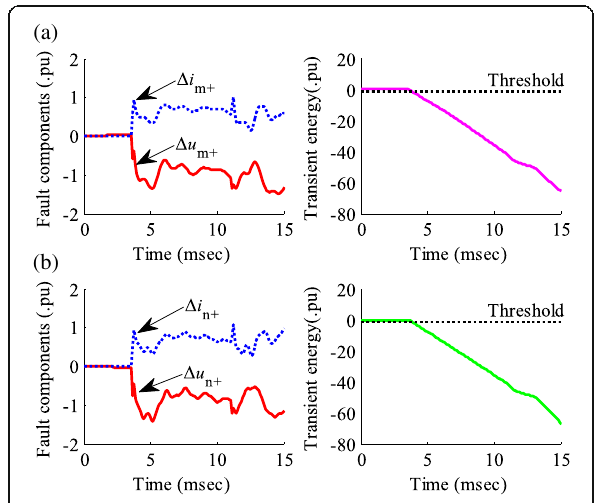
Fig. 10 Waveforms of fault components and transient energies detected on the positive pole line for a fault at F 3. a Rectifier station. b Inverter station